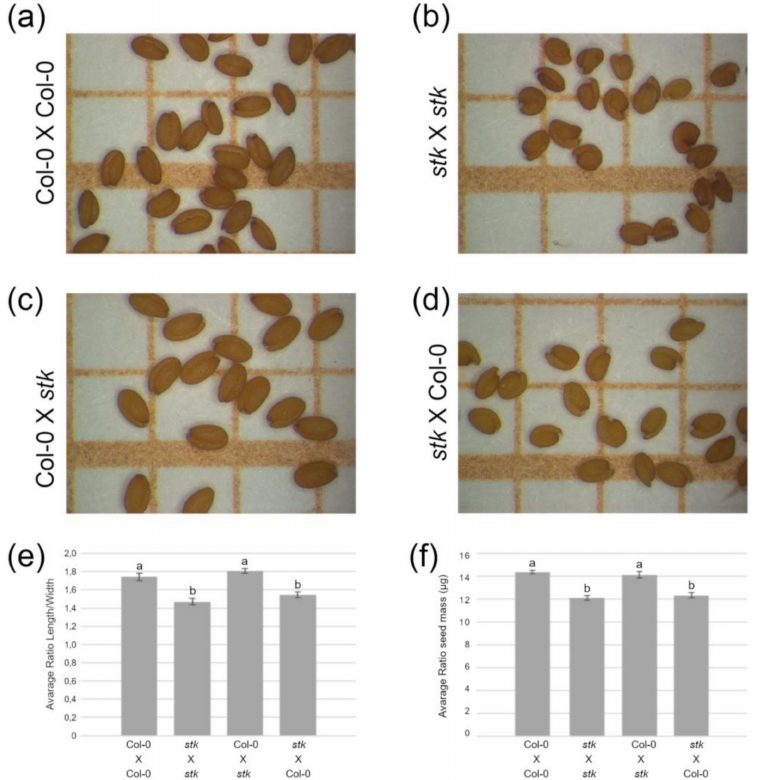
Figure 1. The phenotype of stk mutant seeds has a maternal sporophytic origin. ( a – d ) Seeds of reciprocal crosses between stk and wild-type Columbia (Col-0) plants on 1 mm squared graph paper. ( e ) Ratio between seed length and width. ( f ) Seed mass. Bars indicate means plus standard error; different letters above bars indicate statistically significant differences ( p <